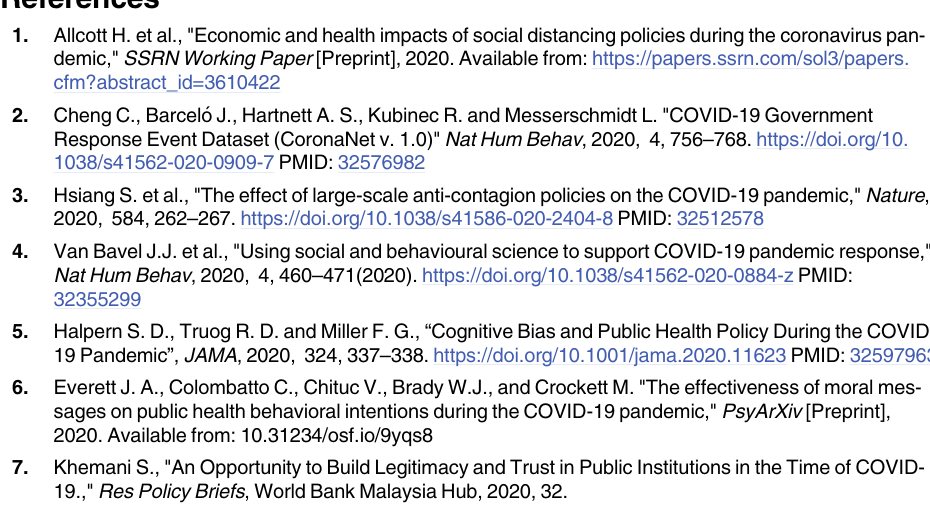
S11 Table. Probit results for self-reported compliance. Probit estimations with individual (gender, age, education and location) and country controls, figures are marginal effects, rela- tive to the benchmark (low expectations and low level of trust), using self-reported compliance before the lockdown as dependent variable.